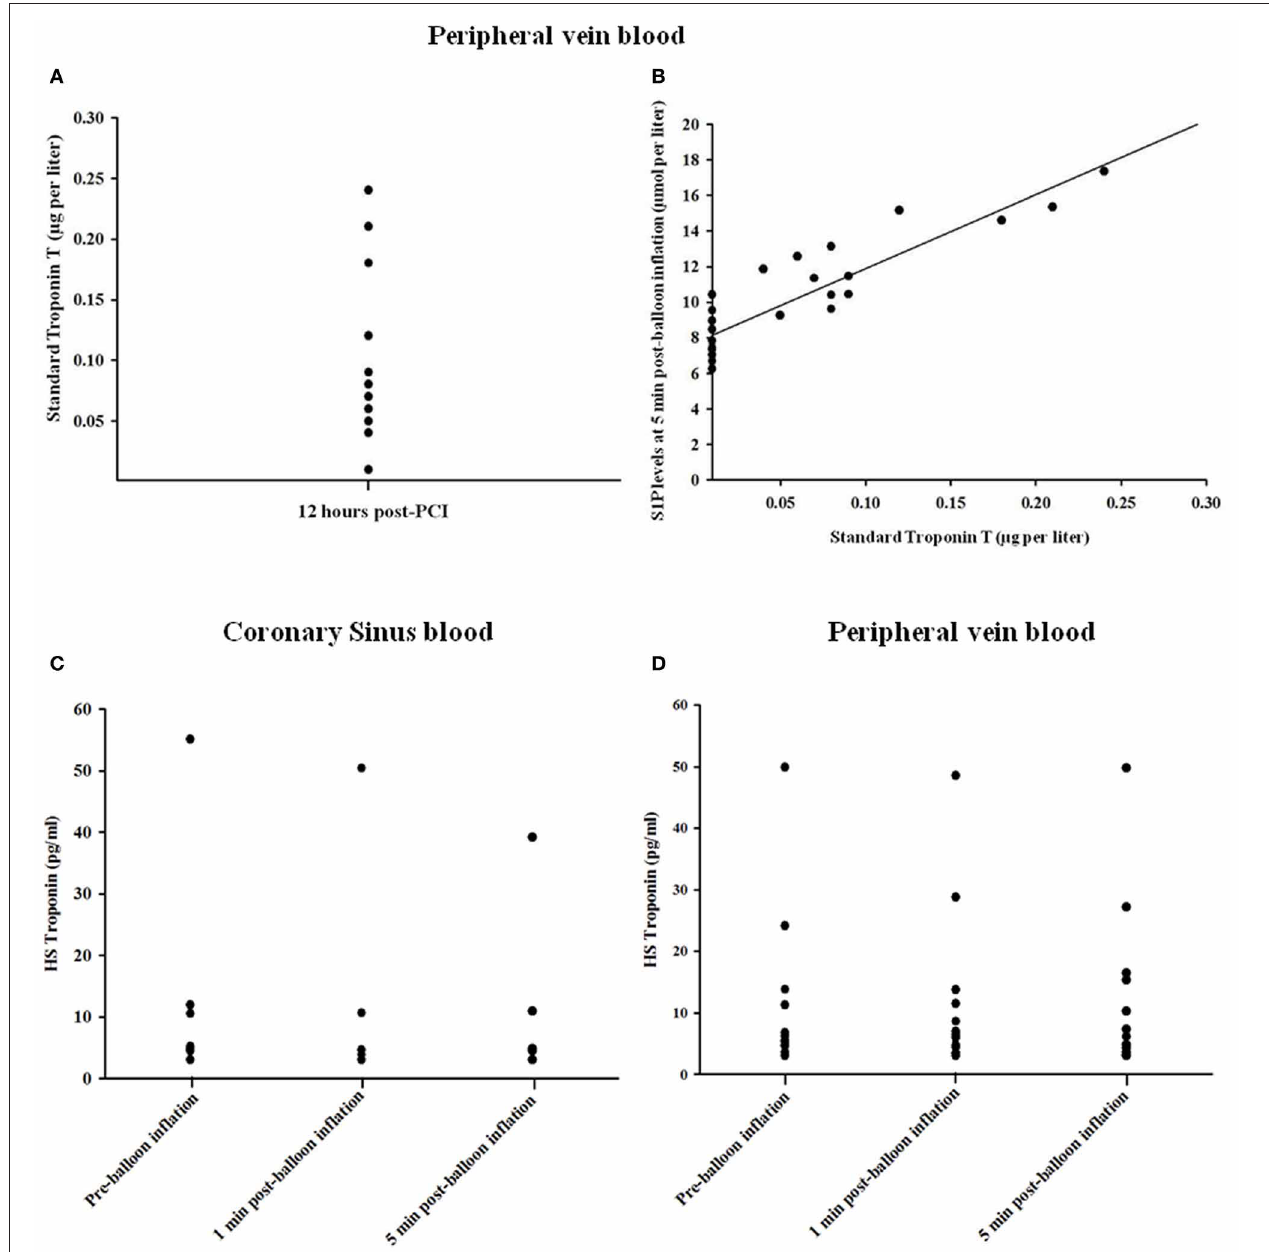
FIGURE 3 | Relationship between troponin T levels at 12h (A) and peak S1P levels (B) in the study participants. In those cases where troponin T was detectable there was close correlation